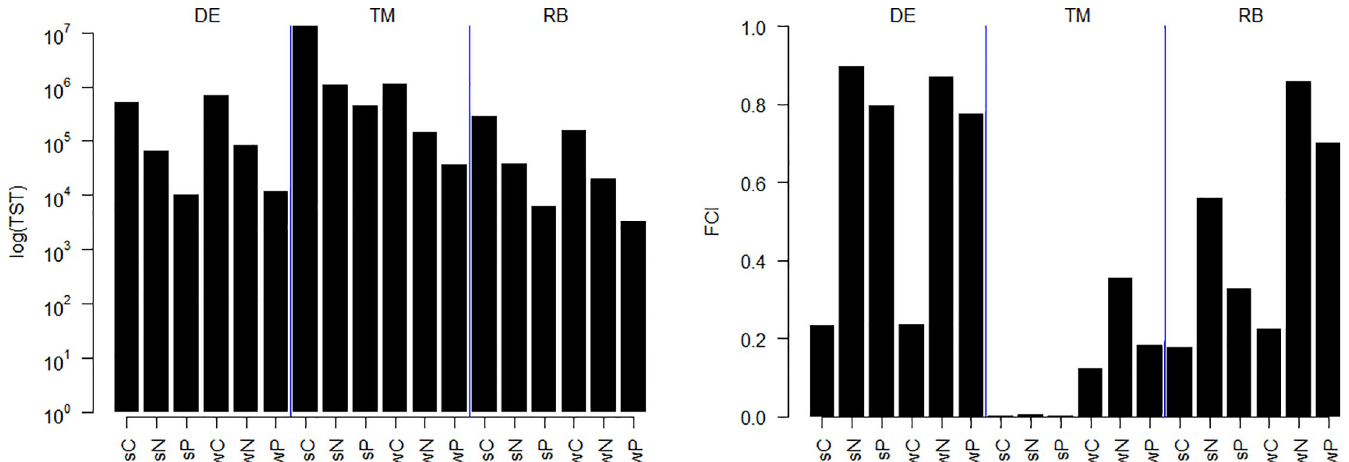
Fig 2. Total system Throughflow (TST) and Finn Cycling Index (FCI) of each network. DE = Durban Eddy, TM = Thukela Mouth, RB = Richards Bay, s = summer, w = winter. C = carbon, N = nitrogen, P = phosphorus.